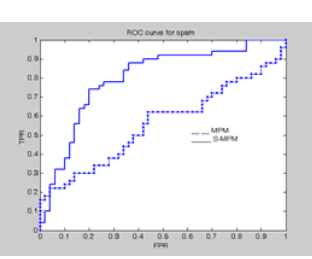
Fig. 5. ROC curves of Spam.